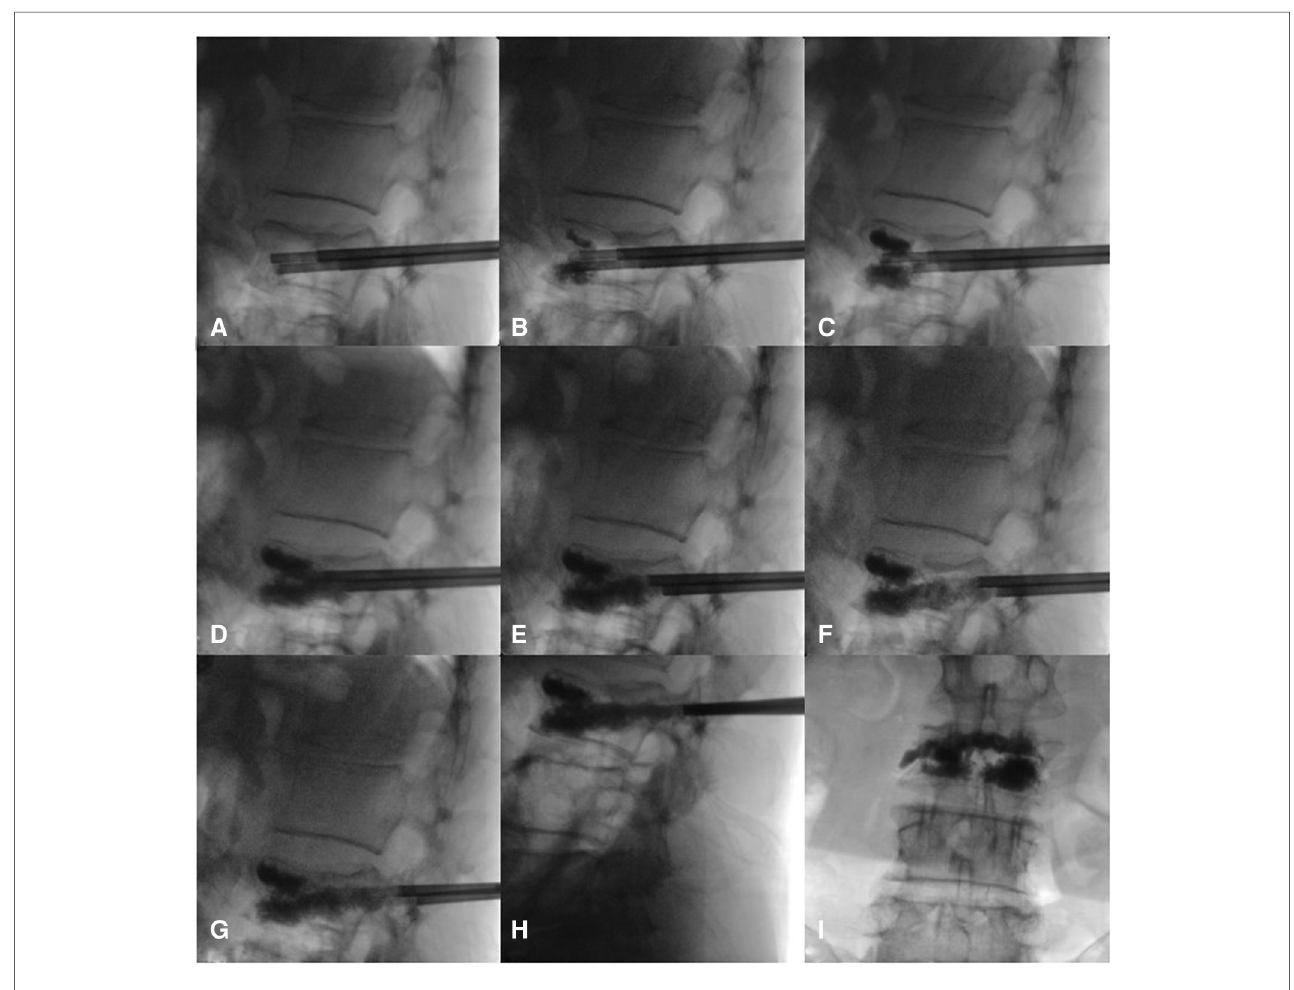
FIGURE 1 ( A – I ) The intraoperative process of bone cement injection and